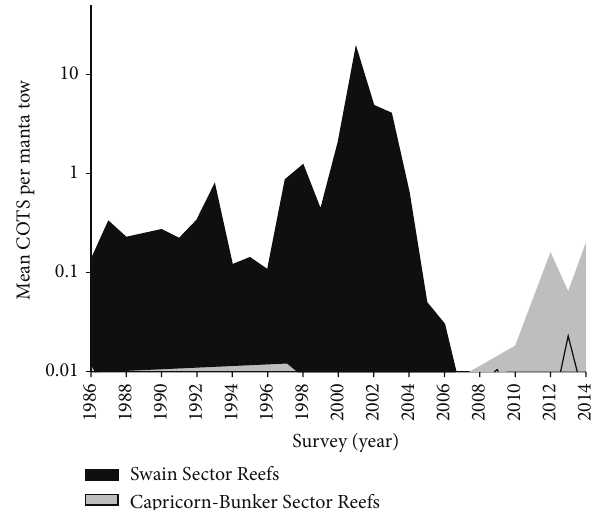
Figure 3: Historic change in COTS abundance on Swain Reefs compared to Capricorn-Bunker Reefs. Surveys conducted in both regions annually except for 1989. Survey years run from 1 July to 30 June, so, for instance, the 2012 survey year represents reefs surveyed between July 2011 and June 2012. 𝑌 -axis log scale, the small line peak in 2013, represents small numbers of COTS recorded from Swain Reef surveys in that year (see Table 1).